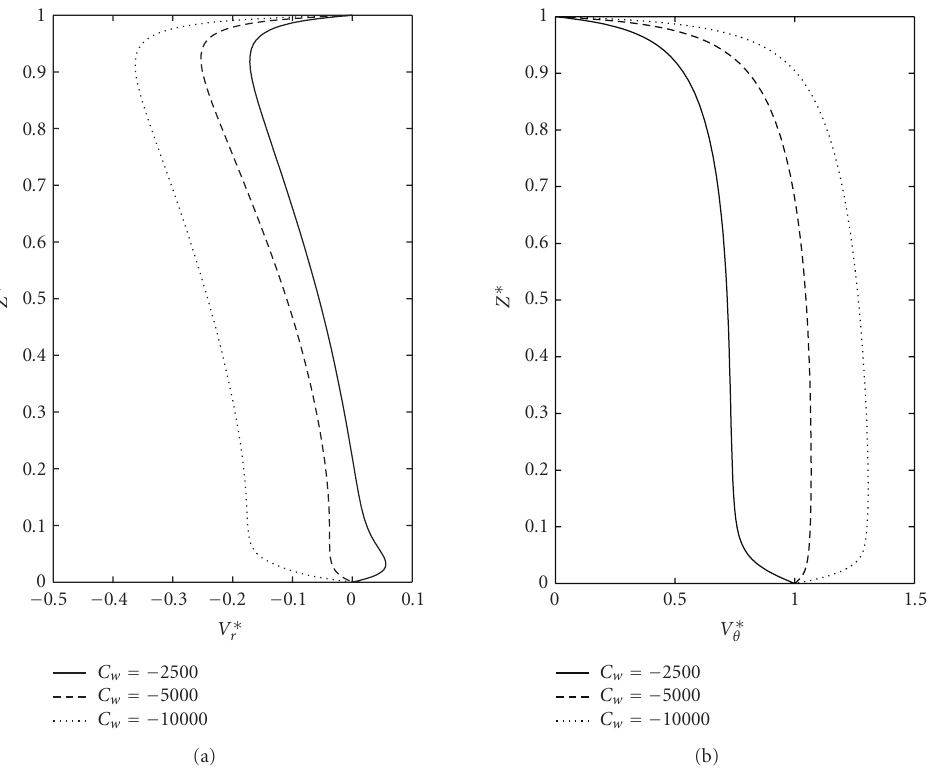
Figure 23: Axial profiles of the mean radial and tangential velocity components for Re = 10 6 , G = 0 . 02 at r ∗ = 0 . 57 and three flowrate coe ffi cients C w >